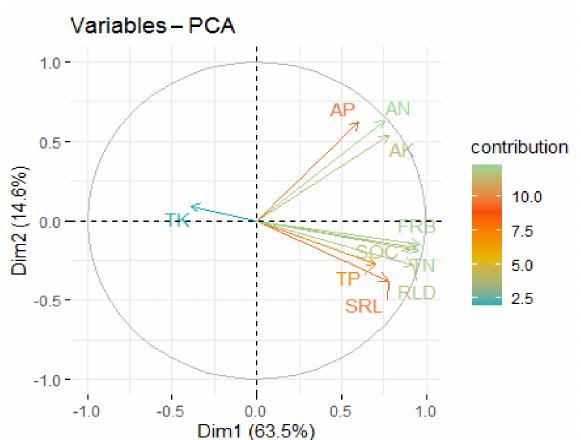
Figure 4. Principal component analysis of variables. The arrow line of the variables is plotted as the correlation coefficients between them and the first two principal components in the unit circle; colors indicate the contributions (%) of variables to the variance in a given principal